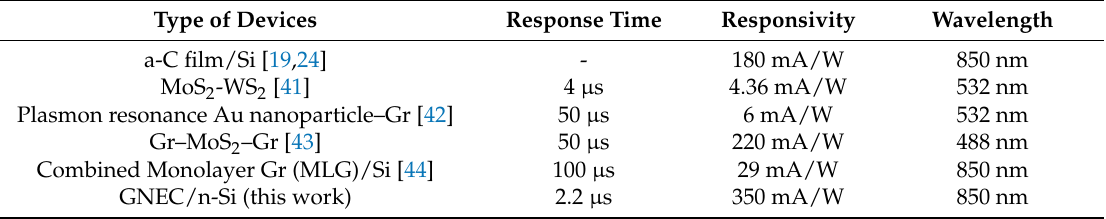
Table 1. Summary of device parameters of several typical 2D material photodetectors previously reported and our own